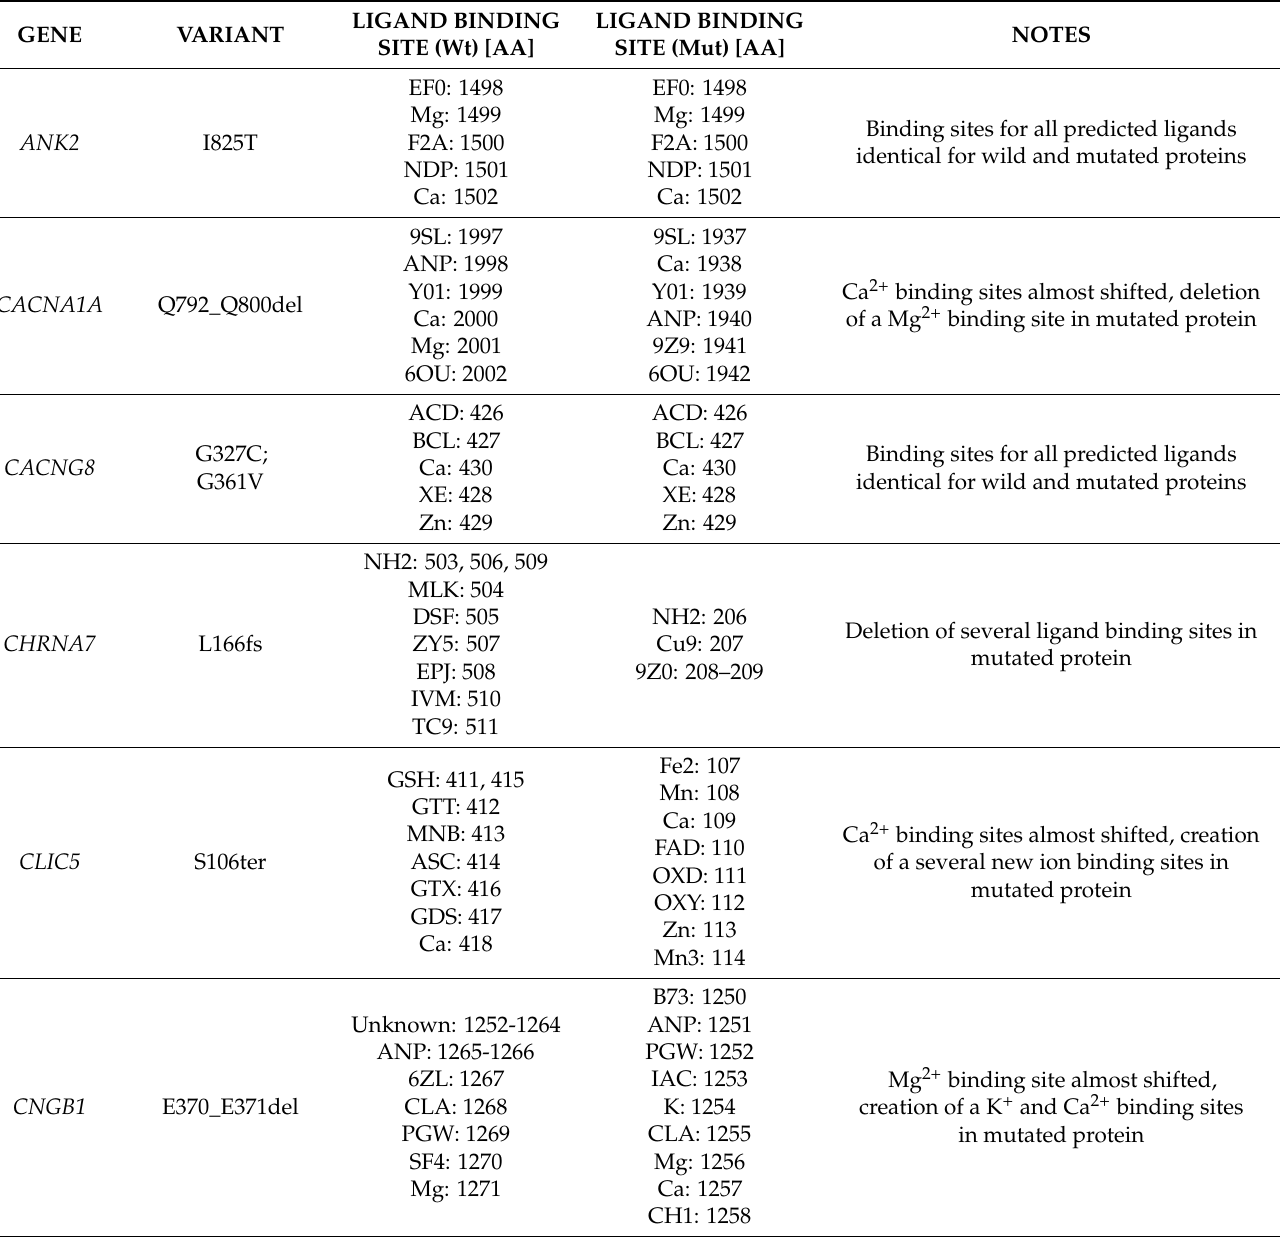
Table 5. Details of binding site differences between wild-type and mutated forms of ion channel-related proteins. All pre- dicted structure of evaluated ion-channel related proteins showed the insertion/loss of important binding sites or a folding impairment due to the presence of detected variants. The complete explanation of complex ligands is available in the dictionary of chemical components on PDBeChem Ligand Dictionary on Protein Data Bank of EMBL-EBI site